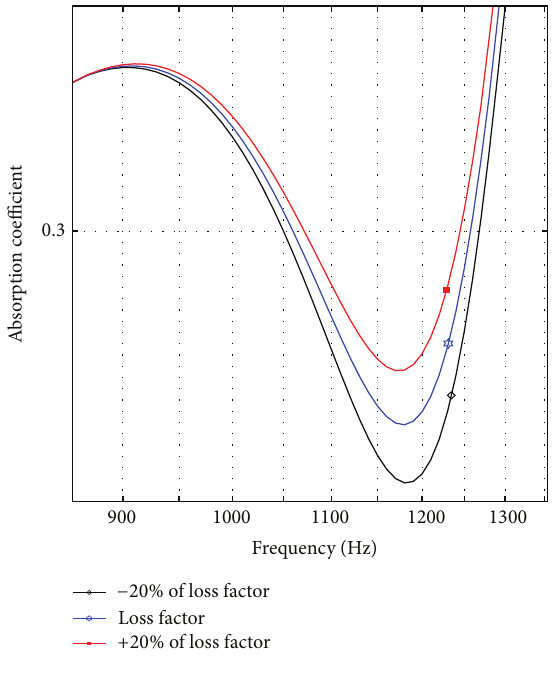
Figure 11: The zoom around of 𝑓 𝑟